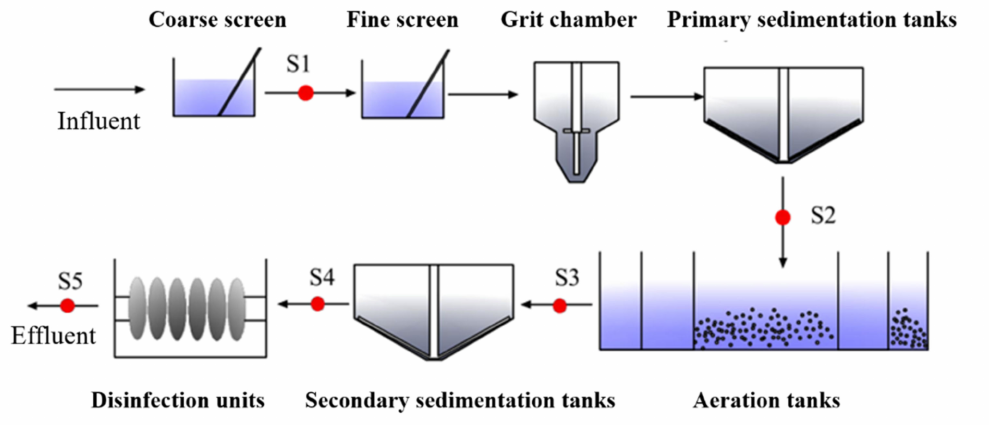
Figure 1. T Schematic diagram of wastewater treatment process of WWTP and sampling points